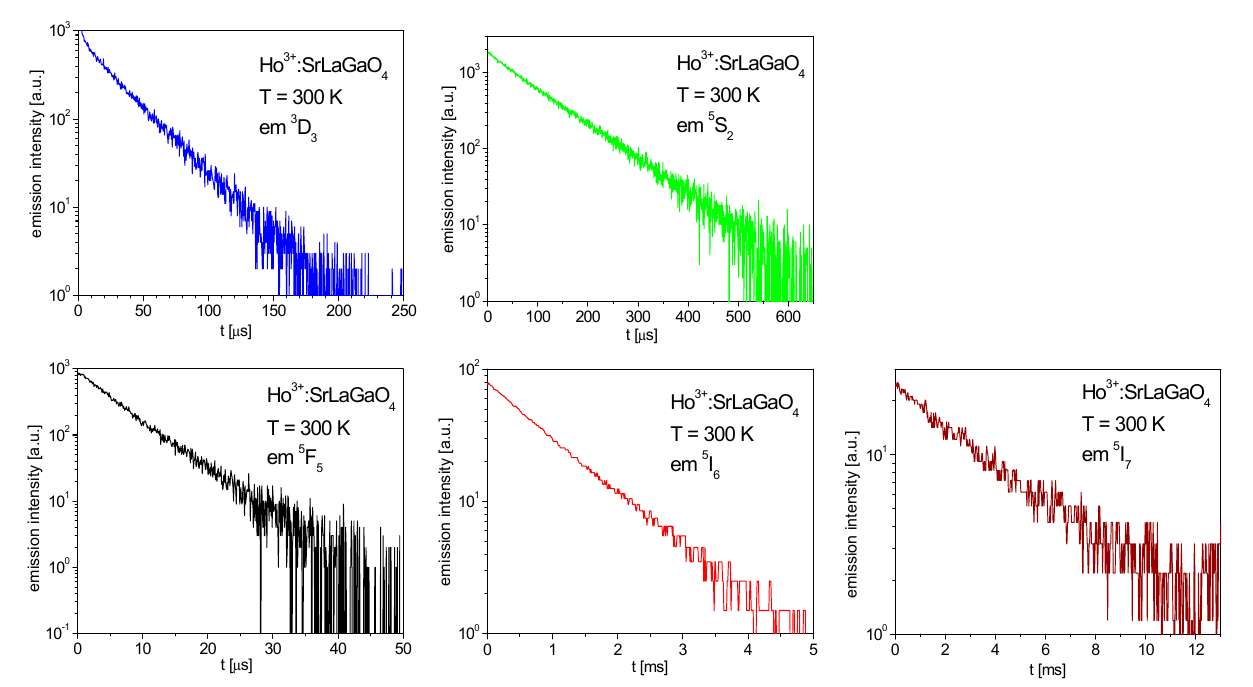
Figure 5. Decay profiles of the 3 D 3 , 5 S 2 , 5 F 5 , 5 I 6 and 5 I 7 emission in Ho 3+ doped SrLaGaO 4 crystal measured at 300 K. Knowing values of radiative and measured lifetimes, the rates of multiphonon relax- ations can be simply calculated using the equation: